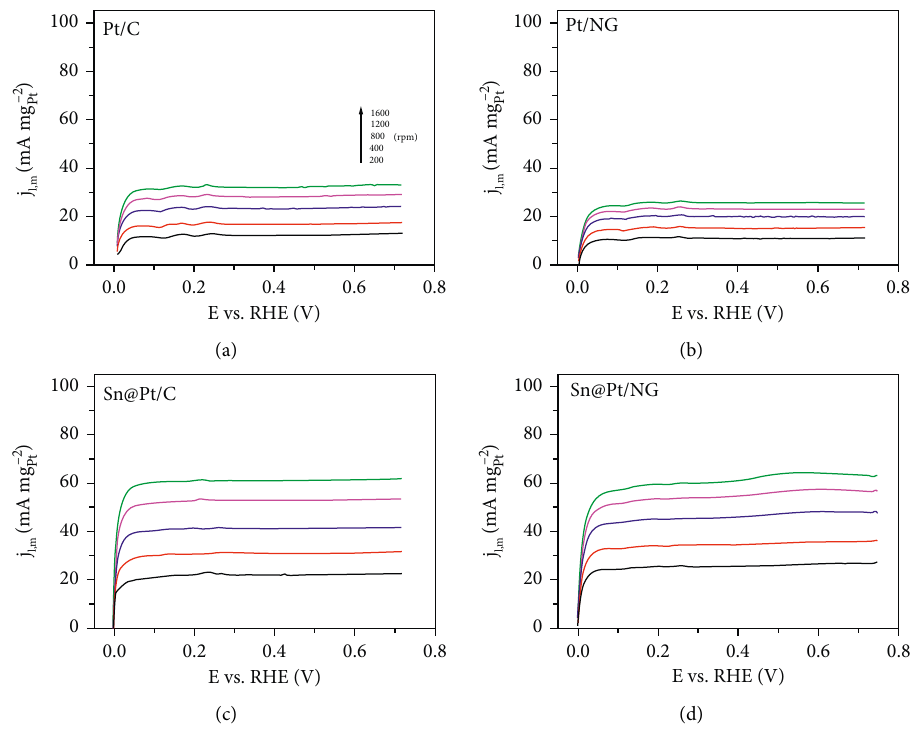
Figure 5: Mass activity of the HOR at (a) Pt/C, (b) Pt/NG, (c) Sn@Pt/C, and (d) Sn@Pt/NG at several ω . Electrolyte: H 0.5M · H 2 SO 4 . Scan rate: 5mV · s − 1 .